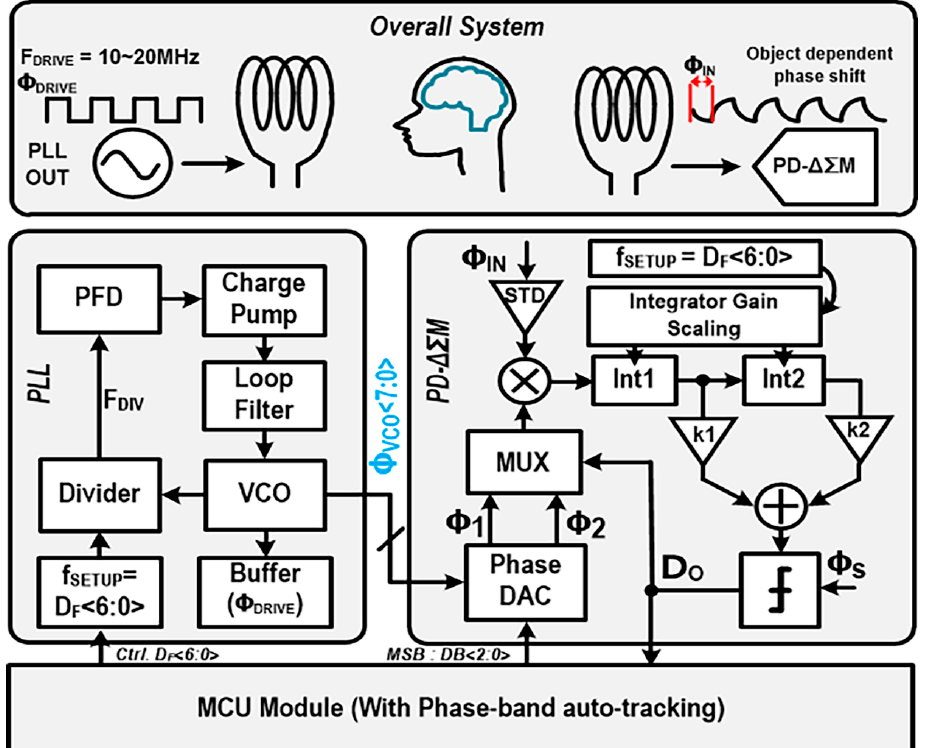
Figure 2. Block diagram of proposed portable MIT transceiver.